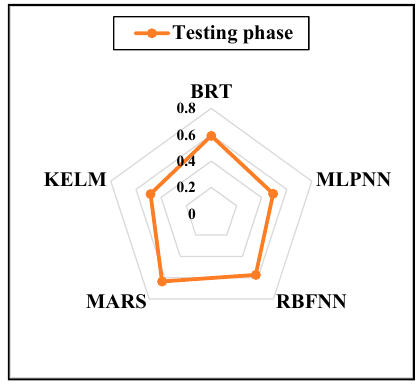
Figure 7. Comparison of RMSE values of the best composite models during the testing phase (UC Riverside station).